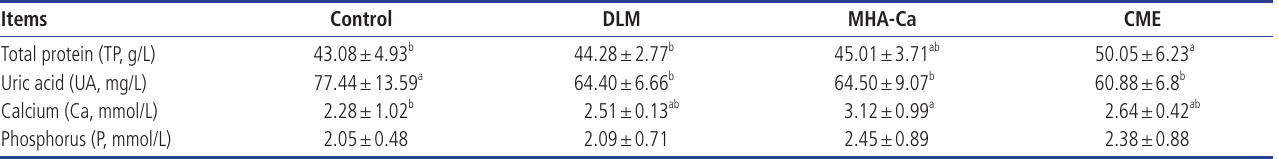
Table 5. Effects of different methionine sources on physiological and biochemical indices in serum of broiler breeders